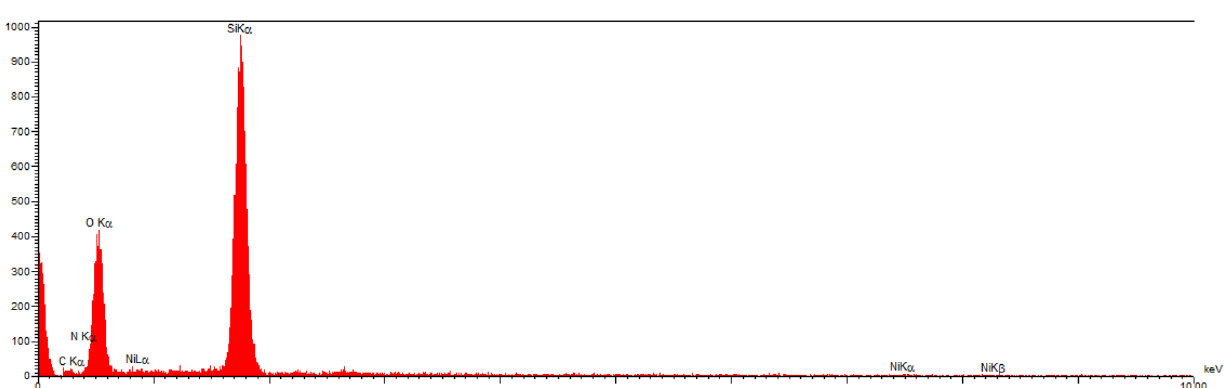
Figure 8. EDX spectrum of